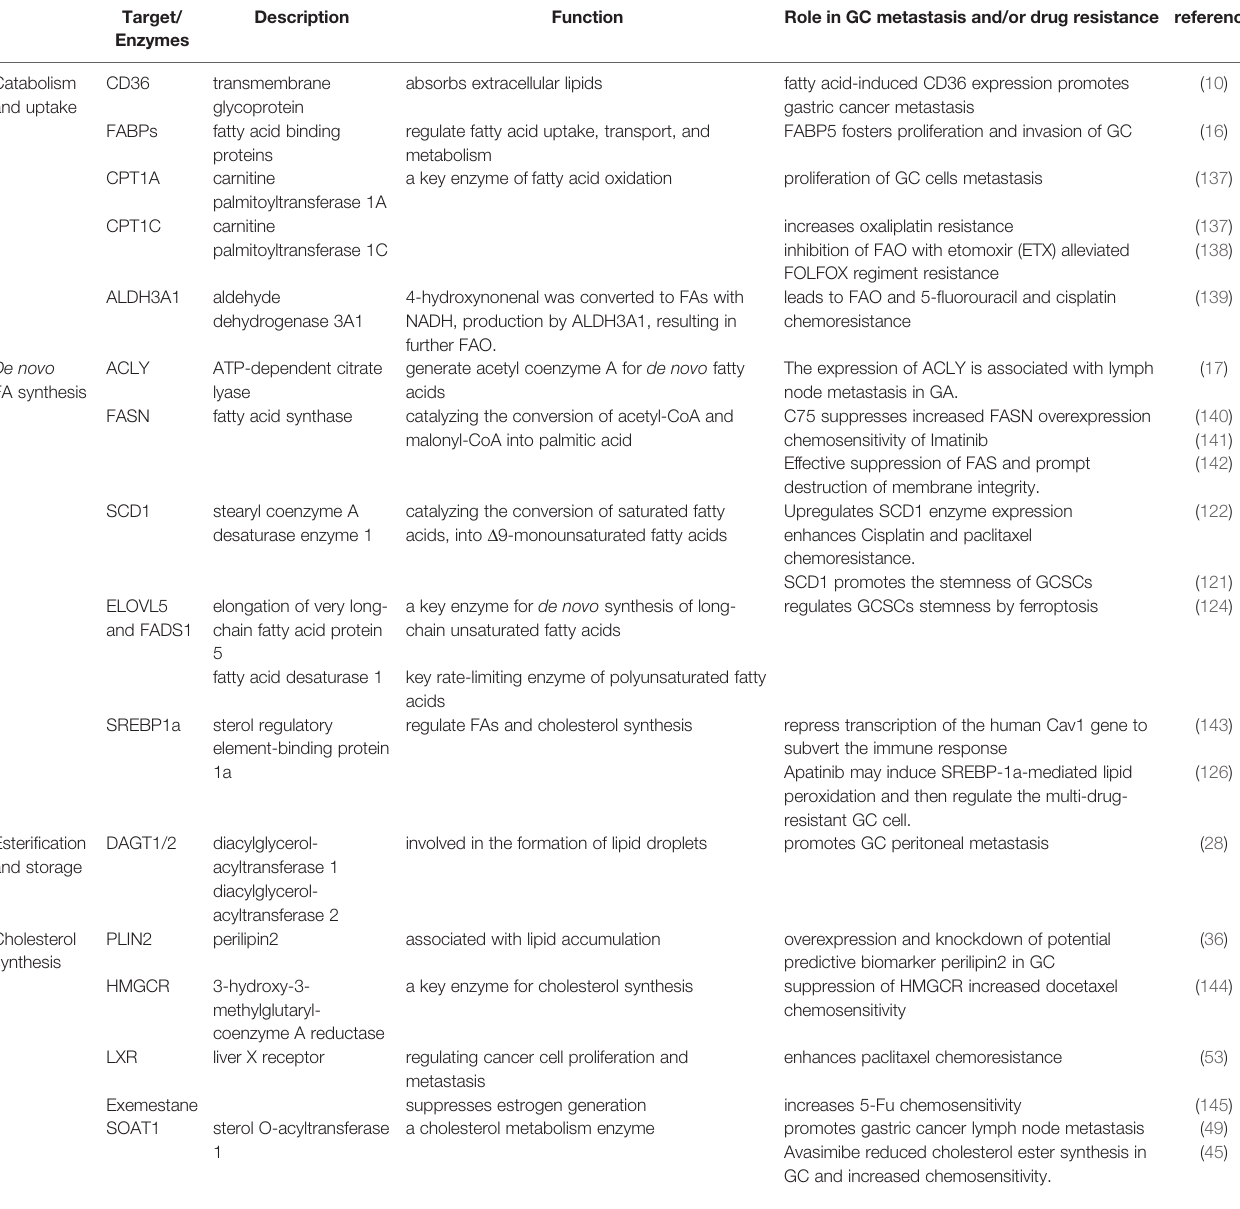
TABLE 1 | Summary of fatty acids related targets/enzymes and their links to GC metastasis and drug